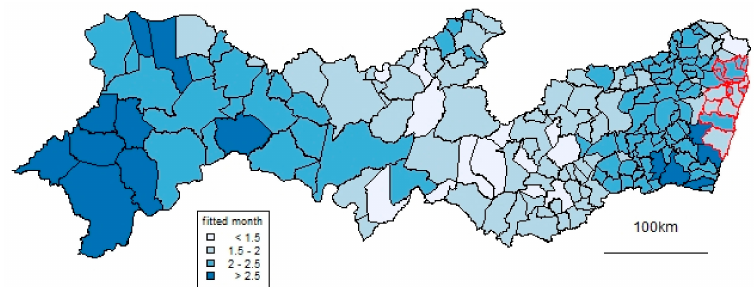
Figure 4. Month when the smoothed prevalence of microcephaly first reached 1 in 500. Lighter colors indicate that this threshold was reached earlier. Month 1 means August 2015, and so on.